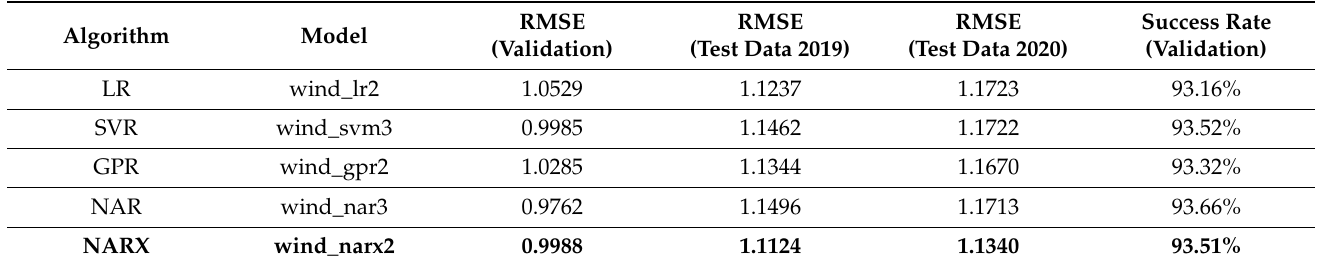
Table 5. Best model results for WSPD forecasting for each ML